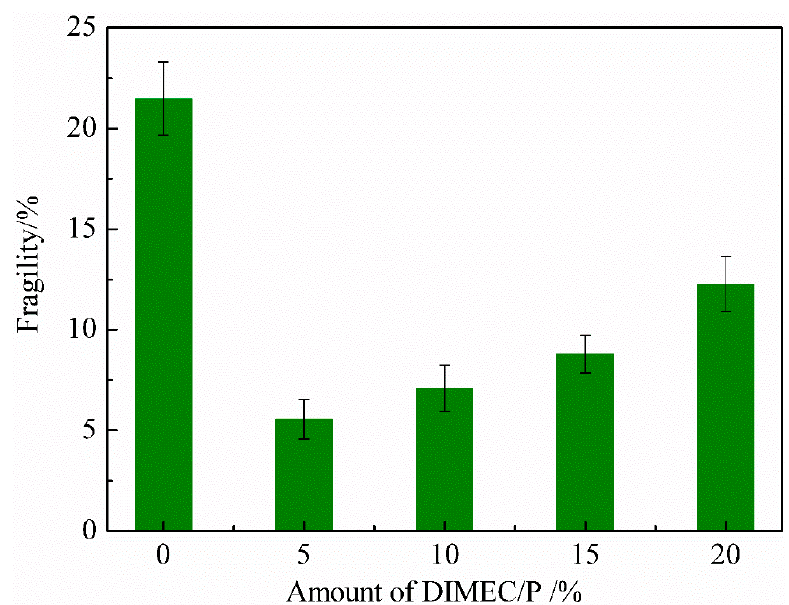
Figure 13. Fragility of CPFs.